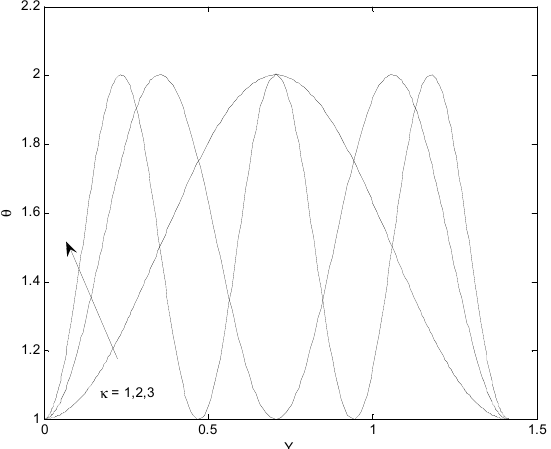
Figure 6. Variation of temperature with amplitude along the hot wall for Ra = 10 6 , Pr = 7, ϕ = π / 4, ε = 0.5.